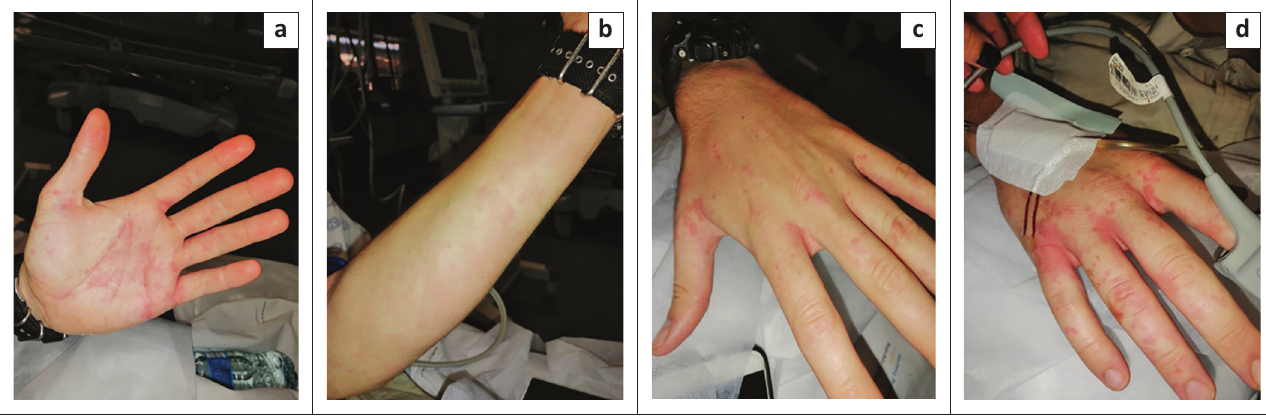
Source : Photos courtesy of patient. FIGURE 3: Rotational thromboelastometry. (a) Day 1 post bite showing abnormalities in the intrinsic and extrinsic pathways, as well as low fibrinogen levels. (b) Done at 16:00 on day 1, showing marked improvement after antivenom administration. (c) Essentially normal rotational thromboelastometry on day 2, but with the fibtem values on the lower end of the normal range. (d) Six hours after the second vial of monovalent antivenom was infused on day 3. a b c